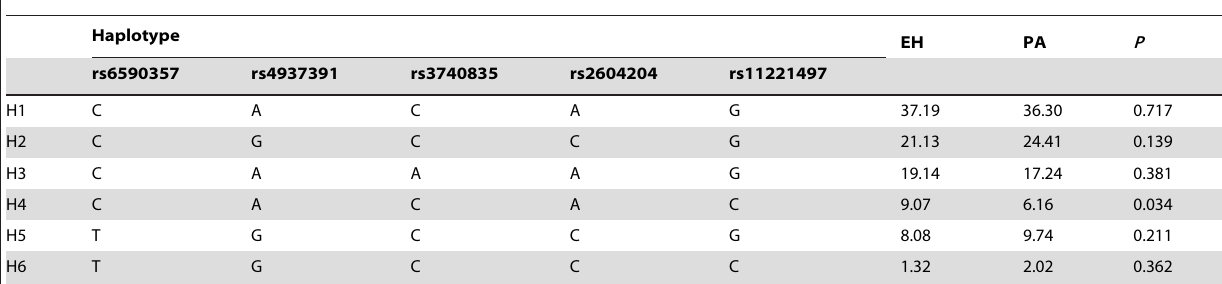
Table 4. Haplotype analysis in PA cases and EH controls.